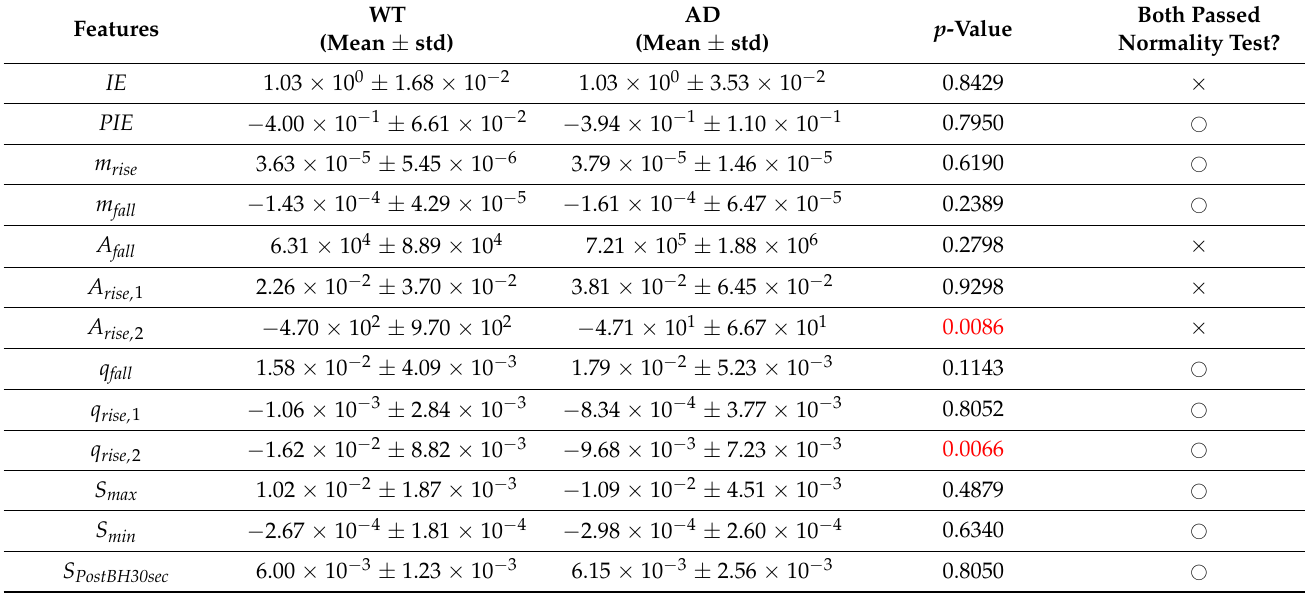
Table 2. Summary of 13 hemodynamic features of ∆ RHb from WT and AD. std: standard deviation. p -value lower than 0.05 is highlighted using red color.